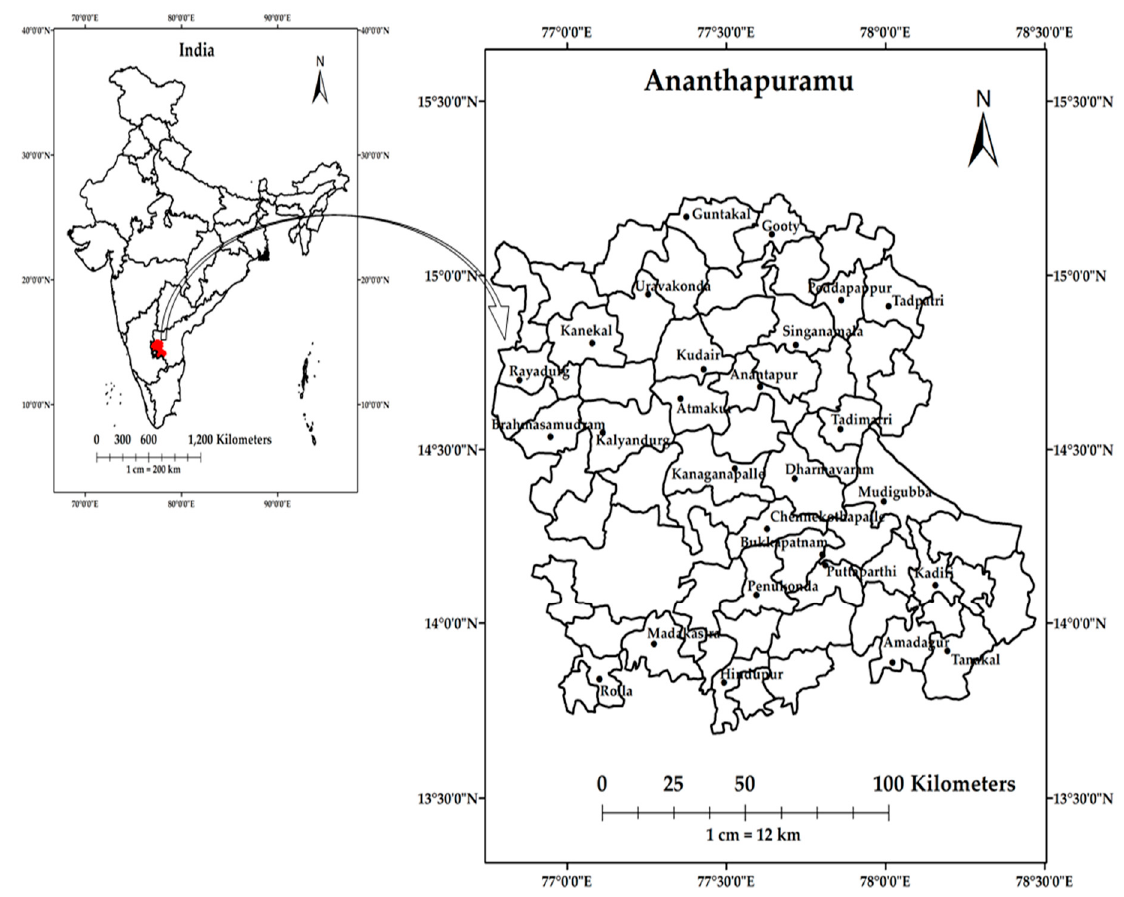
Figure 1. Location map of the study area and rain gauge stations marked as dots.